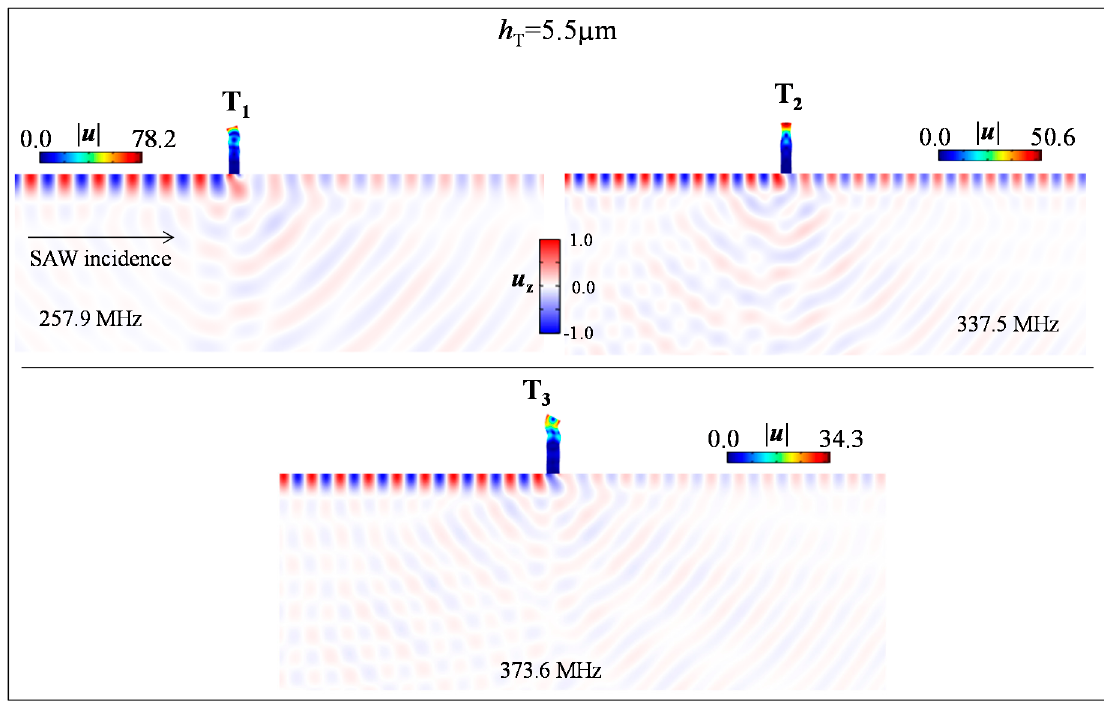
Figure 7. Total displacement field in the ridge as well as the u z component in the Si substrate for SAW at the frequencies of the modes T 1 , T 2 and T 3 indicated in Figure 6 for h T = 5.5 µm.